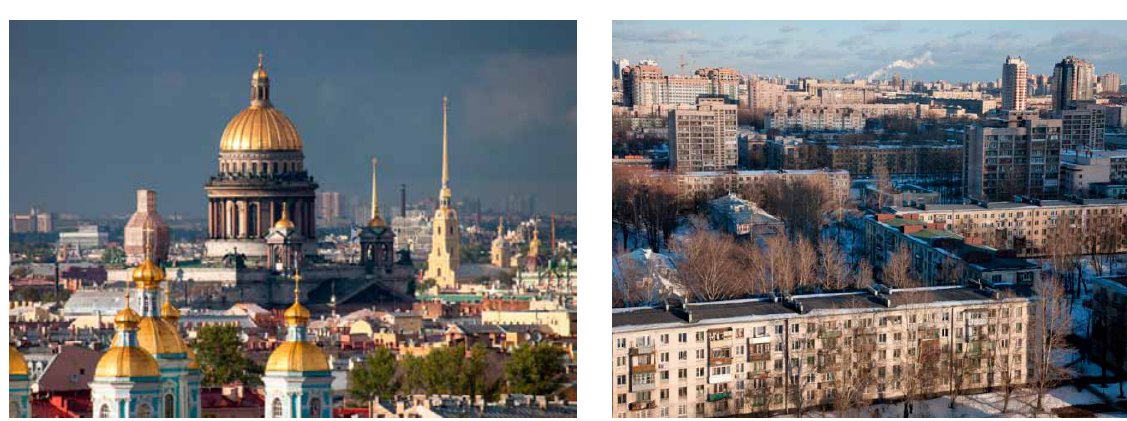
fig. 1. St. Isaac’s Cathedral a significant high-rise accent of St. Petersburg in 1858 (Blinov 2014)